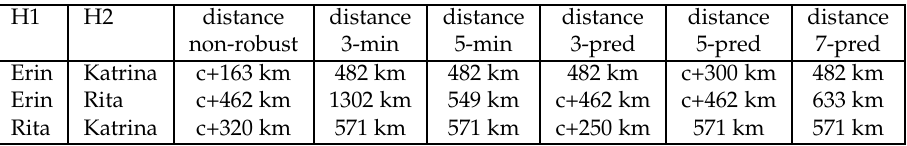
Table 2: Distances between the hurricanes Erin, Katrina, and Rita for a context weight c ≥ 900 . Here, k -min/pred refers to a minimized context cost/predominant context value in a neighborhood of size